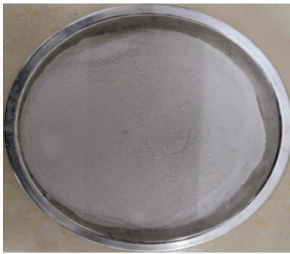
Figure 3. RCP [29].